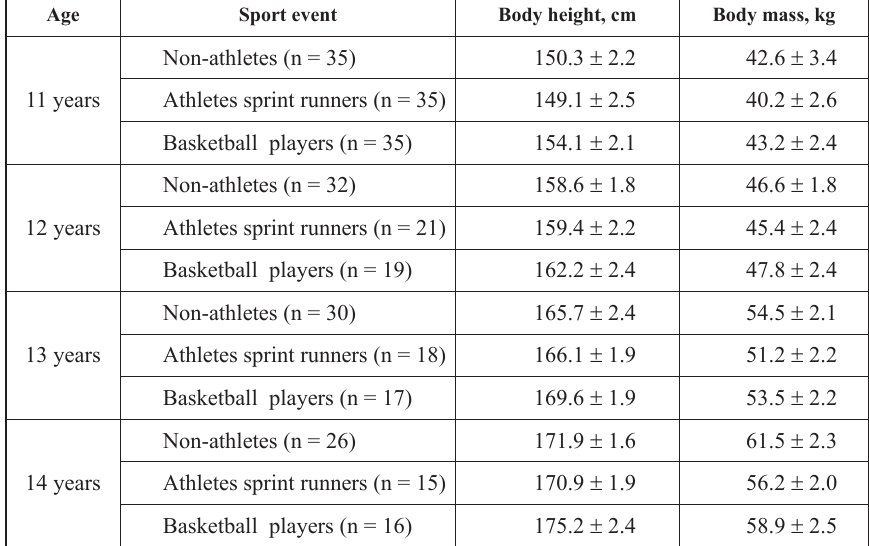
Table. Basic anthropometric characteristics of